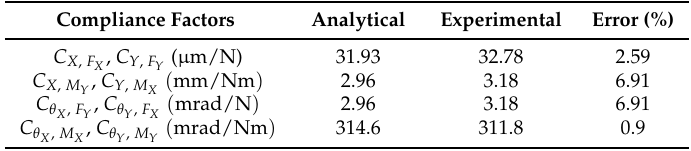
Table 3. Comparisons of compliance factors between analytical and experimental